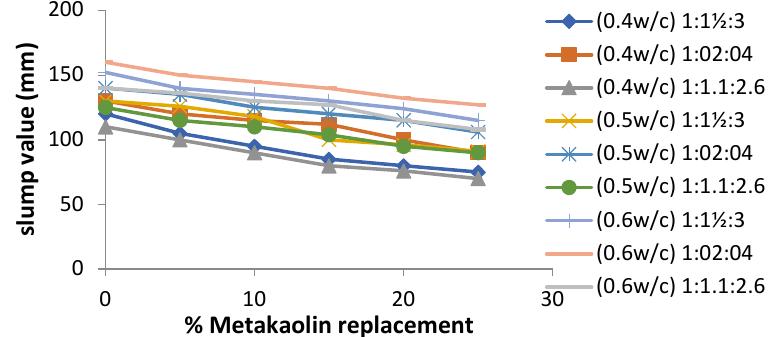
Figure 8. Workability of cement-metakaolin concrete.